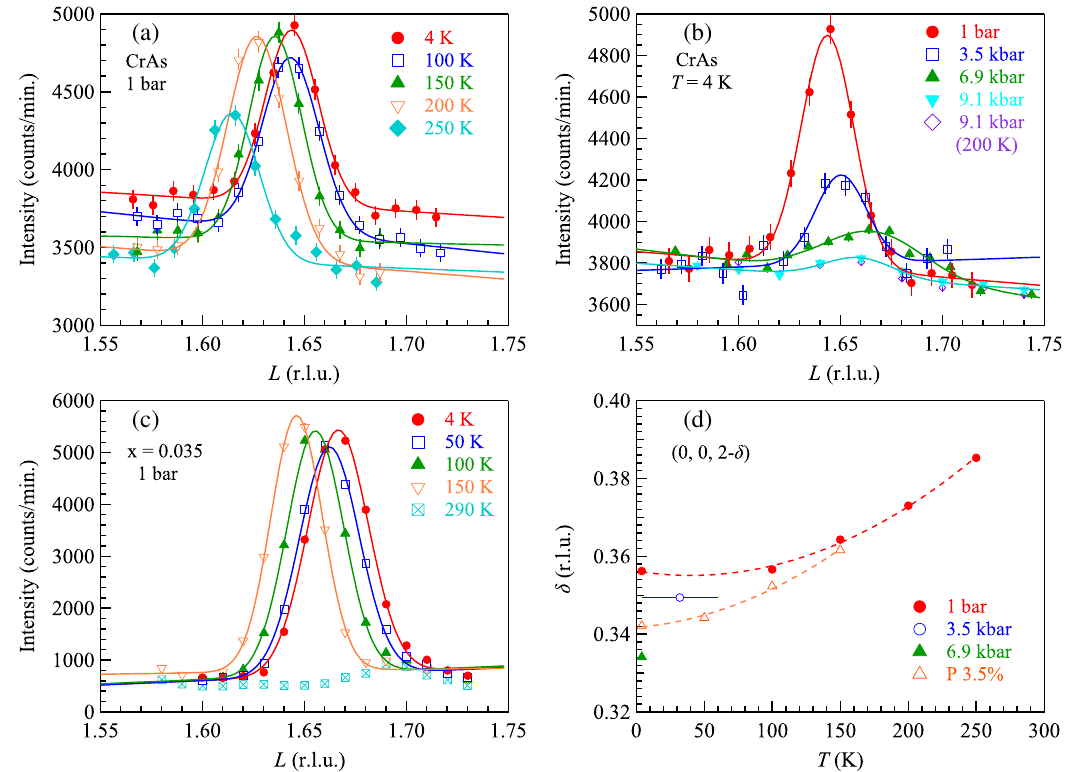
FIG. 2. The (0, 0, 2 - δ ) magnetic Bragg peak for CrAs (a) at different temperatures under 1 bar and (b) under different pressures at 4 K, and (c) for 3.5%-P-doped CrAs at different temperatures under 1 bar. (d) A summary of δ as a function of temperature and pressure for undoped and 3.5%-P-doped